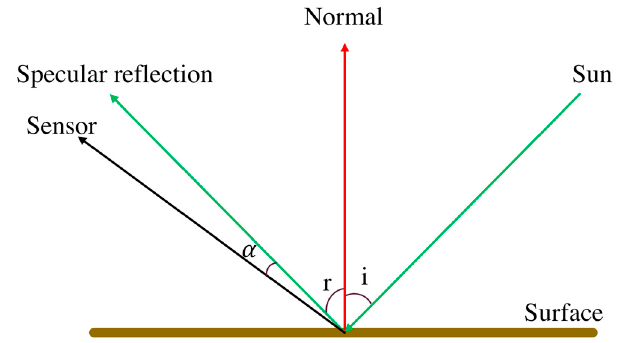
Figure 3. Schematic illustration of specular reflection and specular angle ( 𝛼 ).